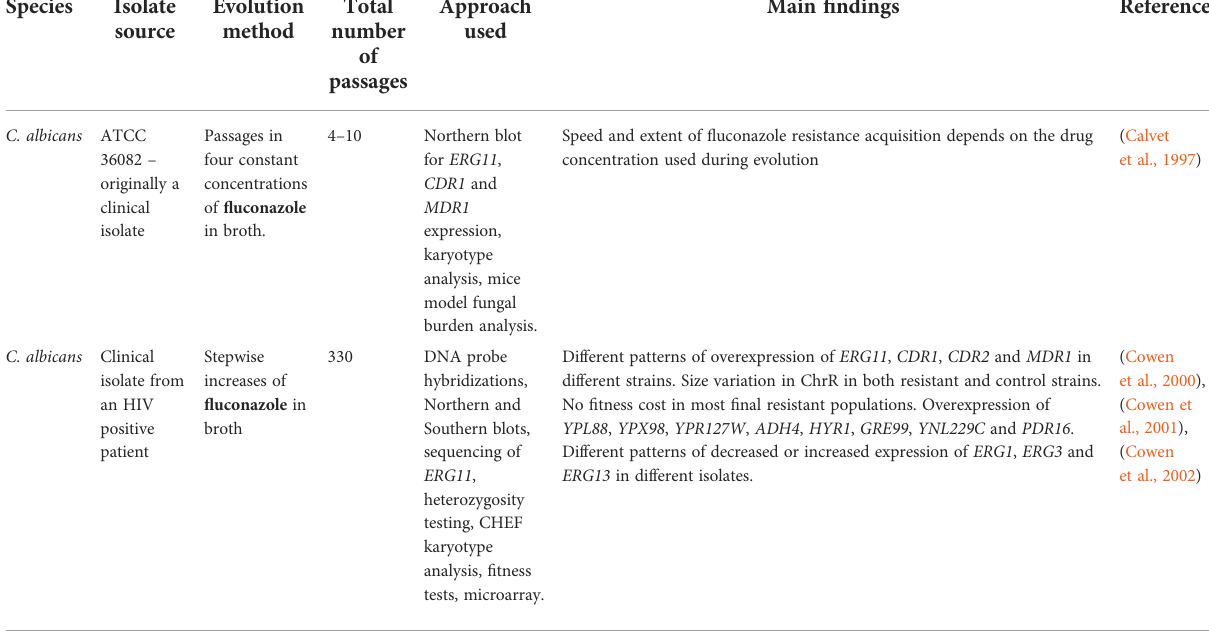
TABLE 3 Development of triazole resistance in Candida spp. isolates undergoing in – vitro